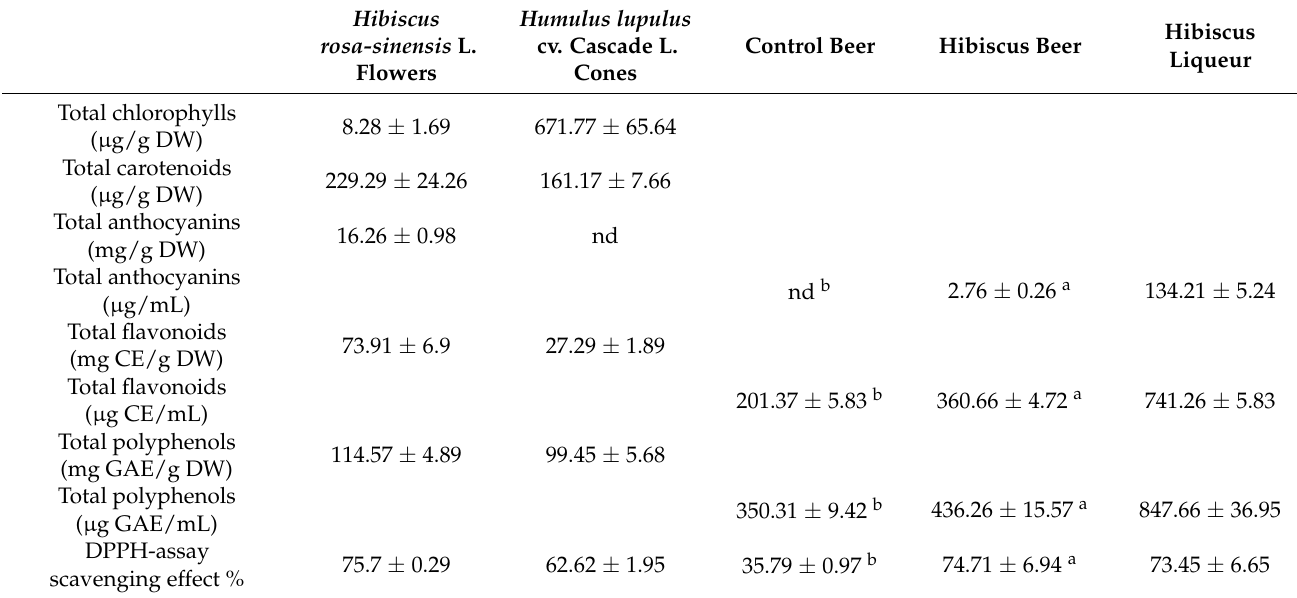
Table 7. Determination of pigments, secondary metabolites, and antioxidant activity of H. rosa-sinensis flowers, H. lupulus cones, control beer, hibiscus beer and hibiscus liqueur. Abbreviations: DW—dry weight; GAE—gallic acid equivalents; CE—catechin